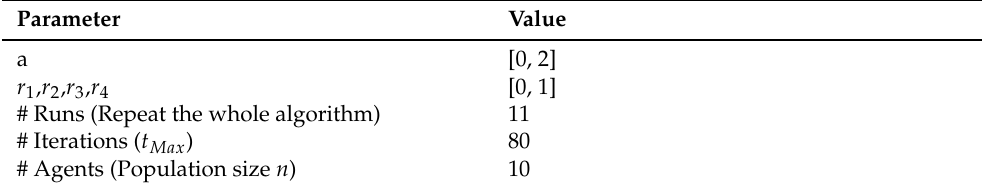
Table 4. Parameters for the ADSCFGWO algorithm’s